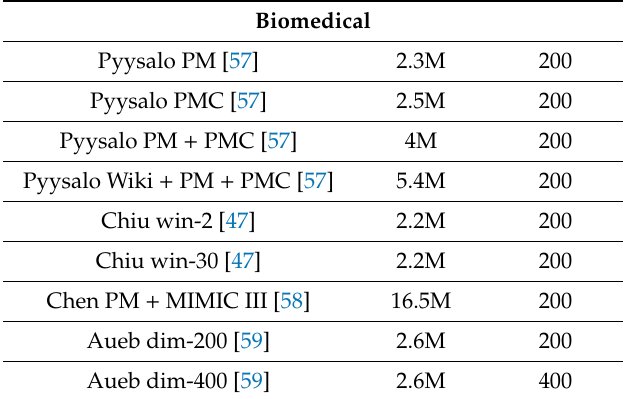
Table A2. Biomedical word